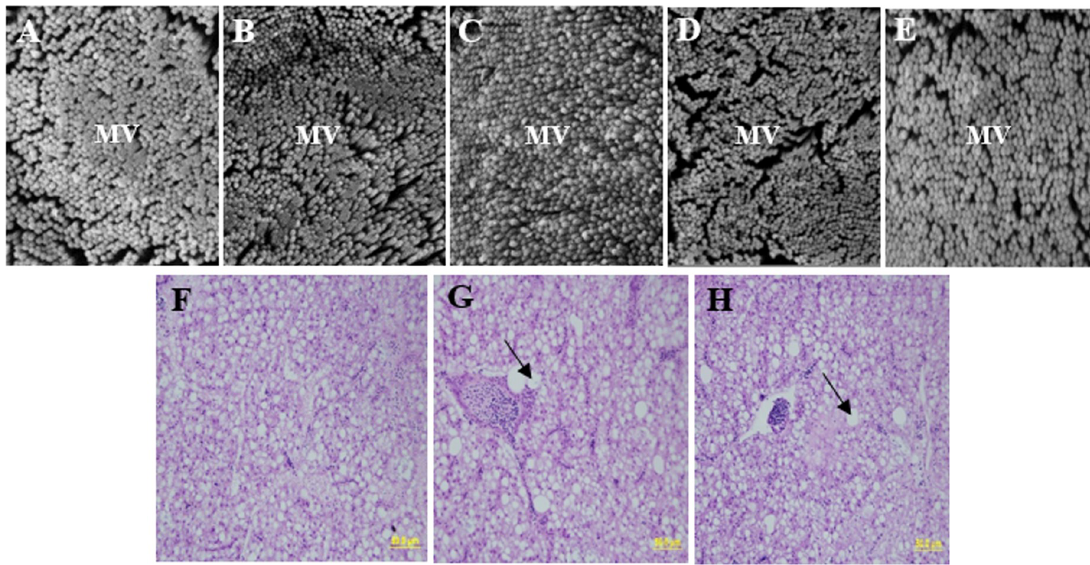
Fig 1. Gut microvilli and liver histological structure of juvenile barramundi. High magnification (x 30,000) electron micrographs showing microvilli in the distal gut of juvenile barramundi fed five experimental diets control, 75PBM, 75BPBM, 100PBM and 100BPBM (Panel A-E). MV = microvilli, Scale bar = 2 μ m, microvilli density count per μ m 2 . Histological structure of the liver of juvenile barramundi fed control, 100PBM and 100BPBM diets (Panel F-H). Black arrow in liver micrographs indicates large vacuoles in hepatic cells (H&E staining, 400x magnification, scale bar = 50 μ